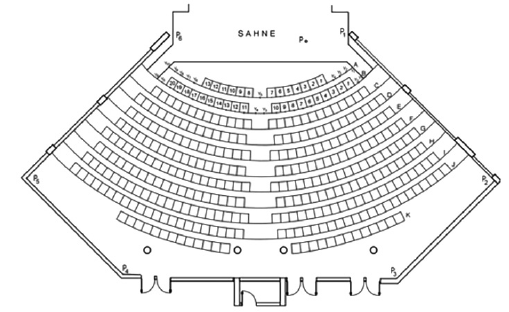
Figure 12. The station point was marked in closed area and other corner points being measured